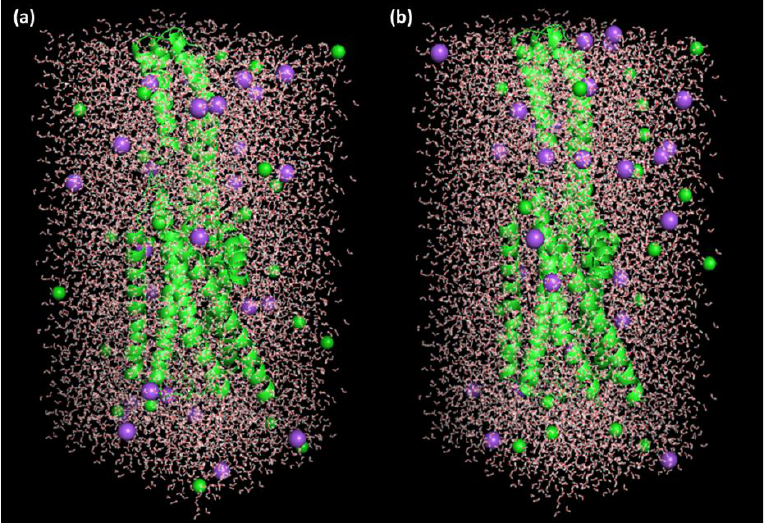
Figure 17. Receptor – ligand complexes, ( a ) RisS and ( b ) CTcS, in triclinic box solvated with water molecules and neutralized with 27 Na + and 27 Cl − ions (0.15 M salt).